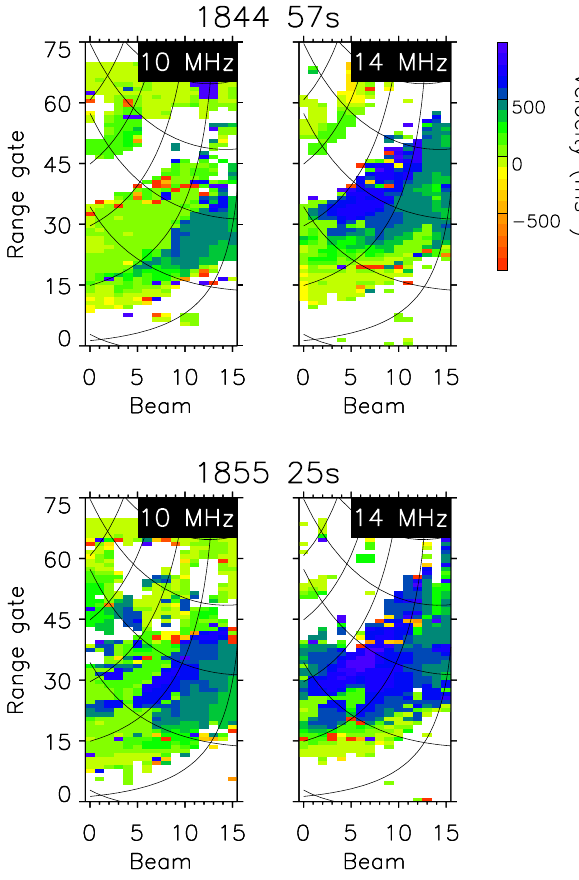
Fig. 9. (Top panels) Doppler shift measurements on channel A and B (10 and 14MHz, respectively) from the scan starting 18:44:57UT. Superimposed curves show constant geomagnetic lon- gitude (top-left to bottom-right) and latitude (top-right to bottom- left). Latitudes are 66 ◦ , 68 ◦ , 70 ◦ , 72 ◦ and 74 ◦ . (Bottom panels) Similar to above, though for the scan starting 18:55:25UT.